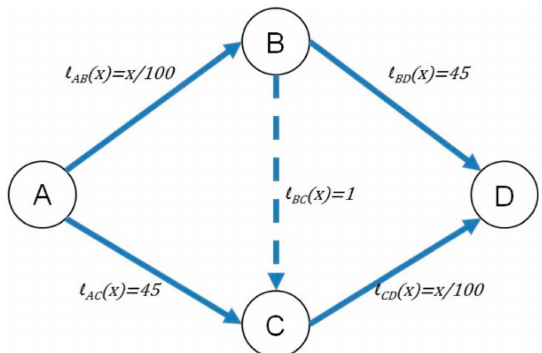
Figure 1. The simple network used to simulate the effect of cognitive agents and demonstrate Braess Paradox. By adding an edge (which should intuitively help) a negative impact on all users of a congested network can be observed. The latency function l of each edge with respect to the number of agents on the edge x is given